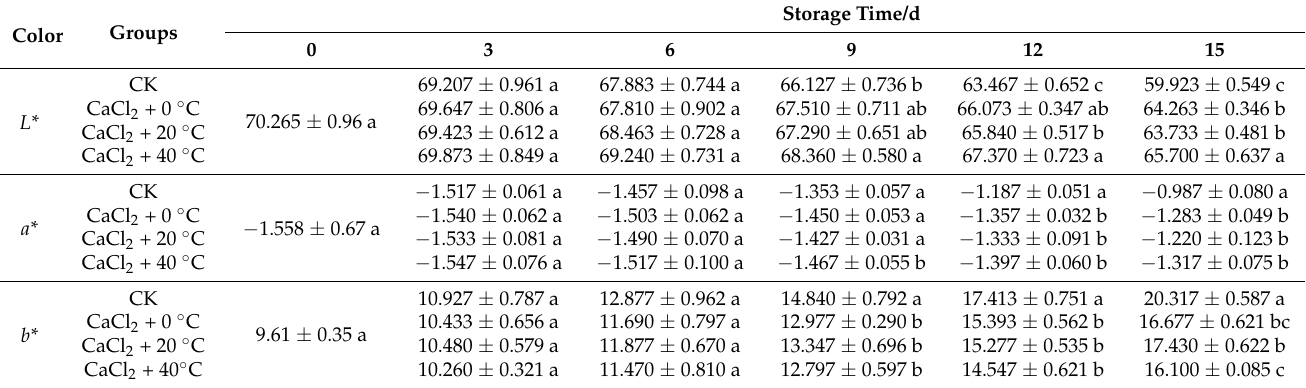
Table 1. Effects of different treatments on the color of fresh-cut “Xuebai” cauliflower